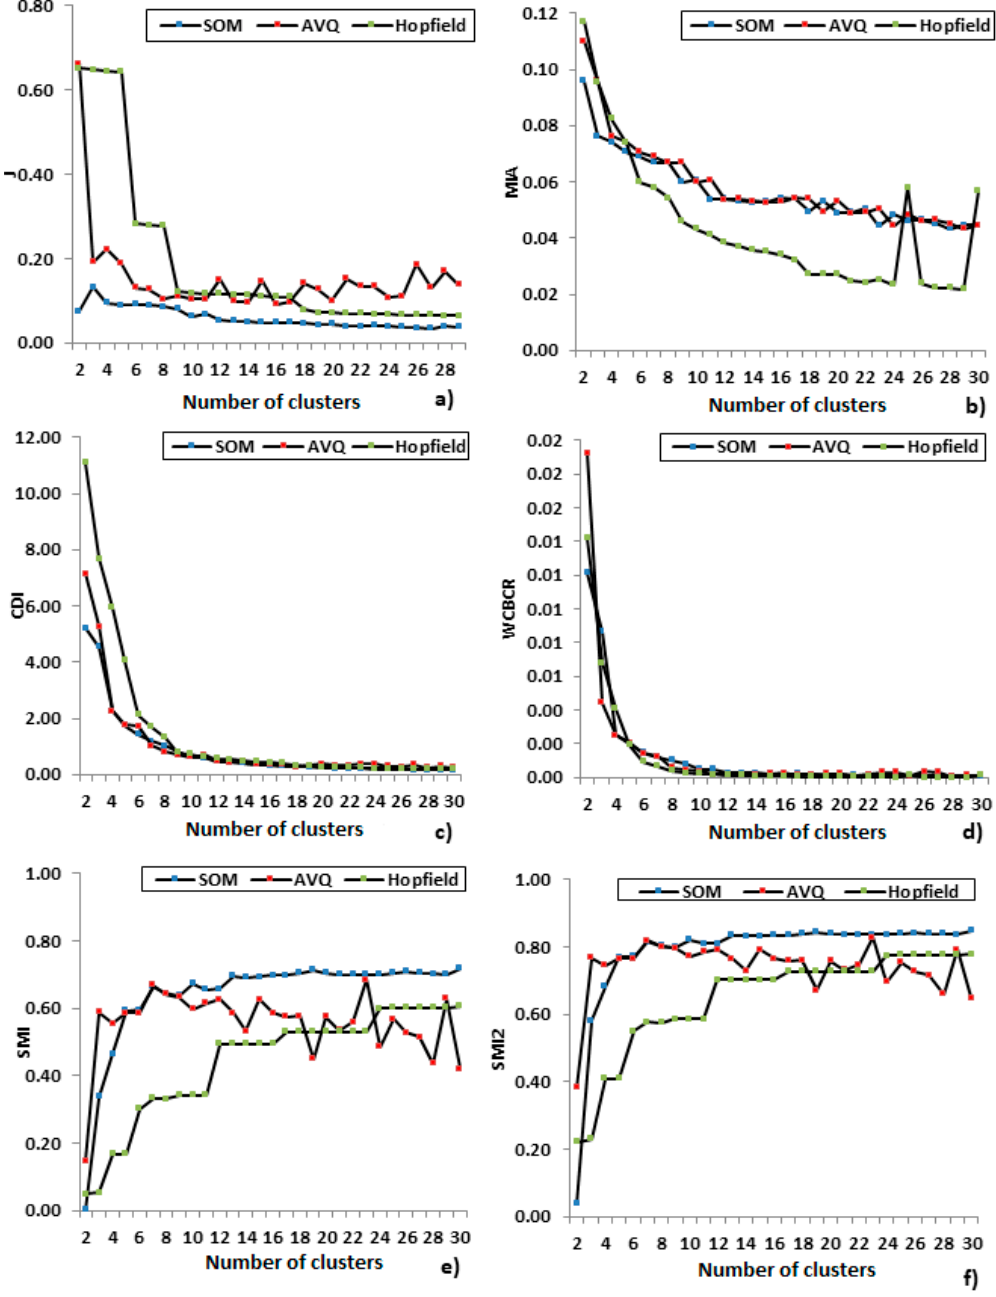
Figure 7. Comparison of the neural network-based algorithms using: ( a ) J, ( b ) MIA, ( c ) CDI, ( d ) WCBCR, ( e ) SMI, ( f ) SMI2.